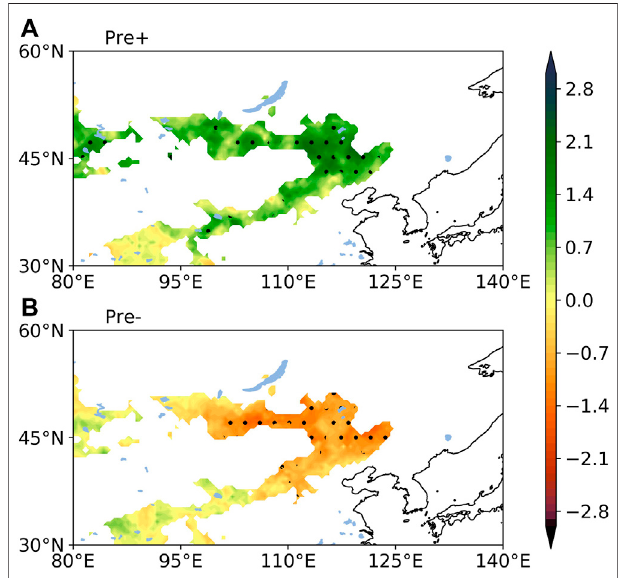
FIGURE 10 | PDSI composite for wet (A) and dry (B) years in the semi- arid regions of East Asia. Stippling denotes the region with statistical signi fi cance at the 90% con fi dence level based on Student ’ s t-test.